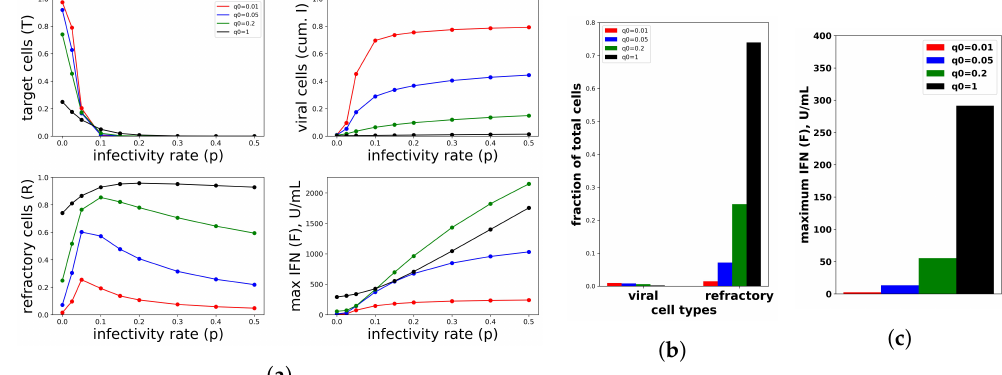
Figure 7. A constant IFN secretion rate cannot simultaneously protect against high infectivity viruses and avoid excessive IFN secretion against low infectivity viruses. ( a ) Shown are the frequency of target cells, T , at the end of infection (top left), the fraction of cells that became virally productive, which is the cumulative number of cells in compartment I (top right), the total frequency of refractory cells, R , at the end of infection (bottom left), and the maximum of the extracellular IFN concentration, F , over the course of infection in U/mL (bottom right) as the viral infectivity rate p is varied. Each colored curve corresponds to a different q 0 , the IFN secretion rate, as specified in the legend. As p increases, protection requires relatively high q 0 values. Panels ( b , c ) are a zoom in of the results in Panel (a) for p = 0, representing an abortive infection. As the secretion rate q 0 varies, the number of virally-productive cells does not change significantly, but the fraction of refractory cells and the maximum IFN concentration levels rise considerably, reflecting excessive IFN secretion. Parameter values not shown: β = 1, φ = 1, a = 1, r = 0.3, δ = 0.05, k = 0.1, c = 0.3, d = 0.15, h = 1, σ =